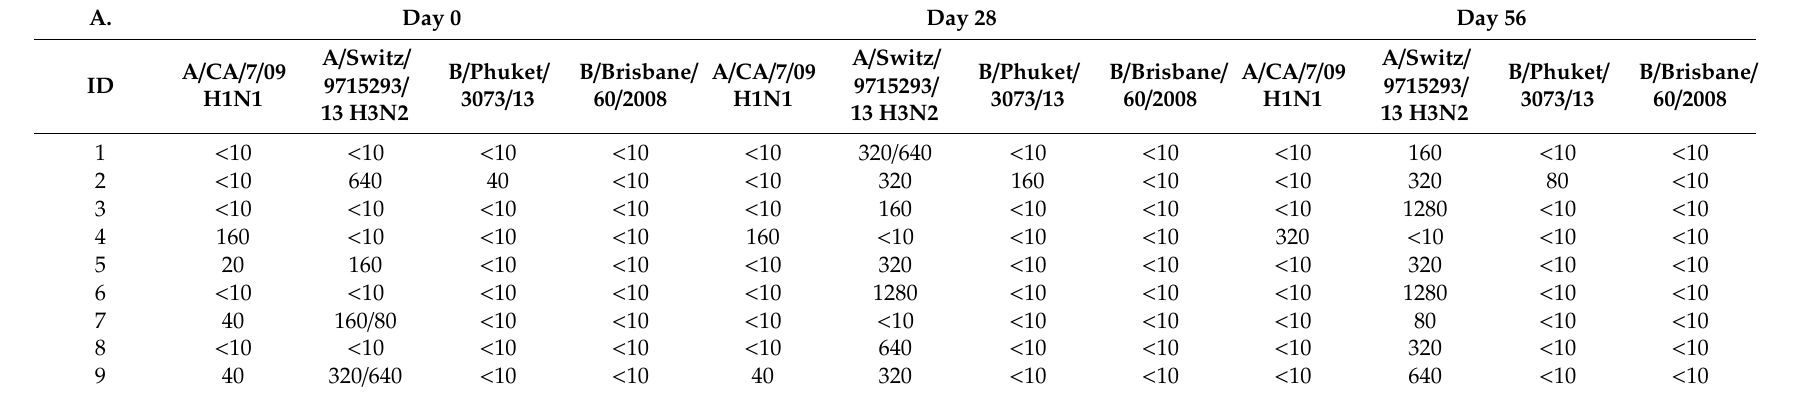
Table A4. HAI results 2015–2016.